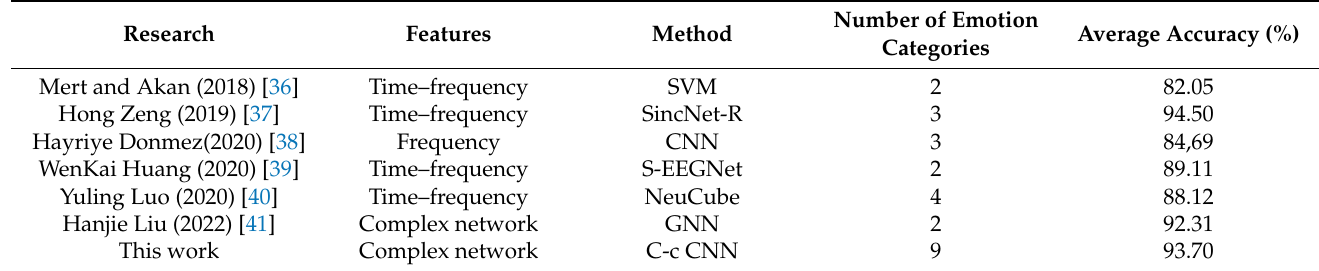
Table 5. Classification accuracies of different